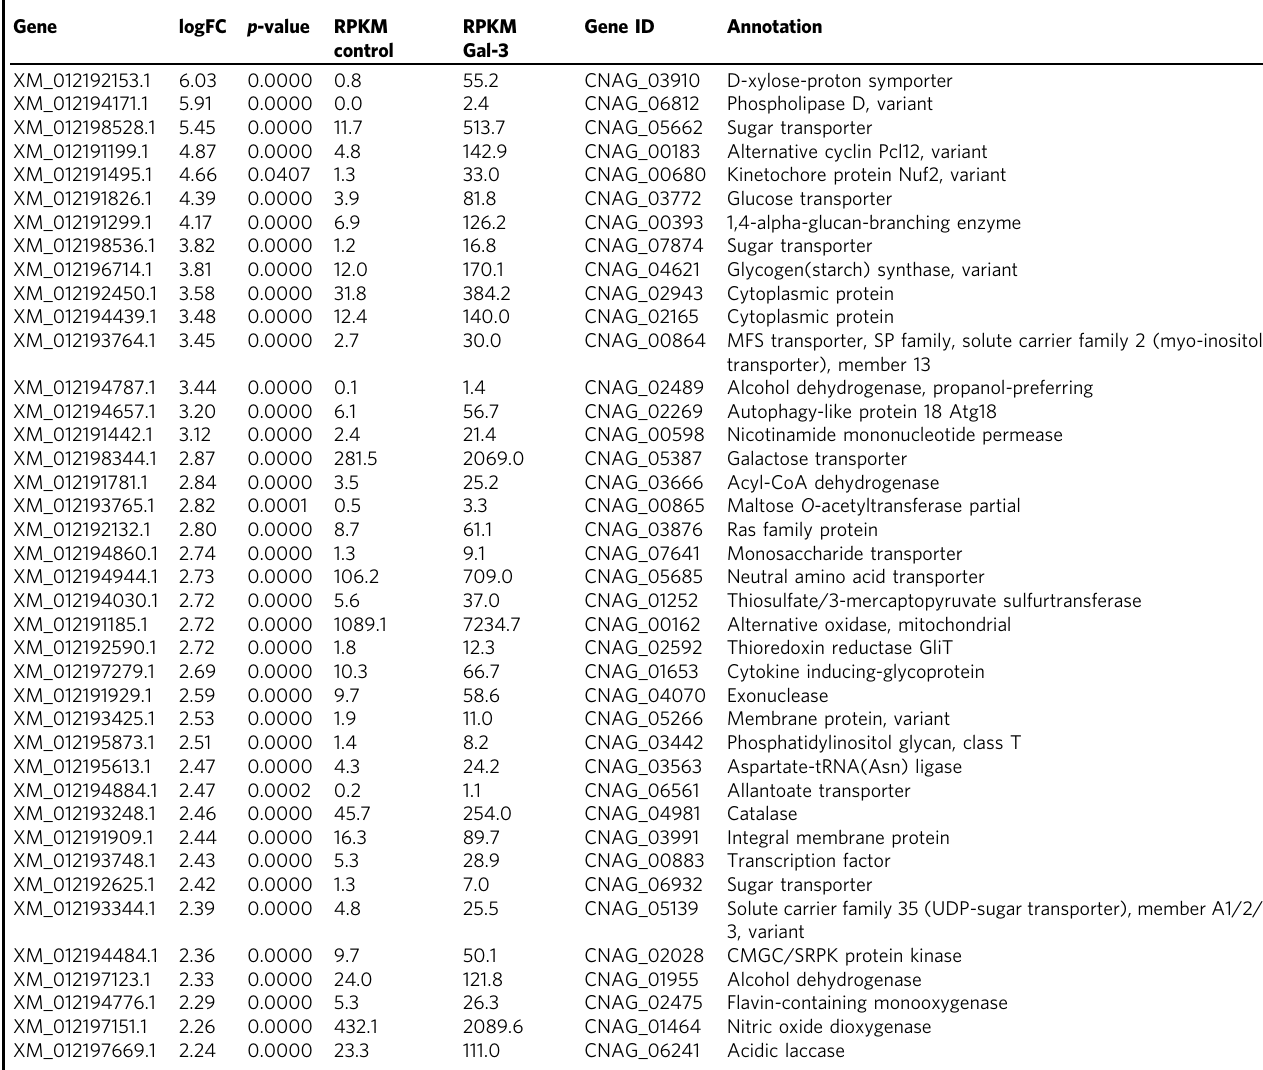
Table 1 List of top 40 induced genes with annotated functions upon exposure to Gal-3 Gene logFC p -value RPKM